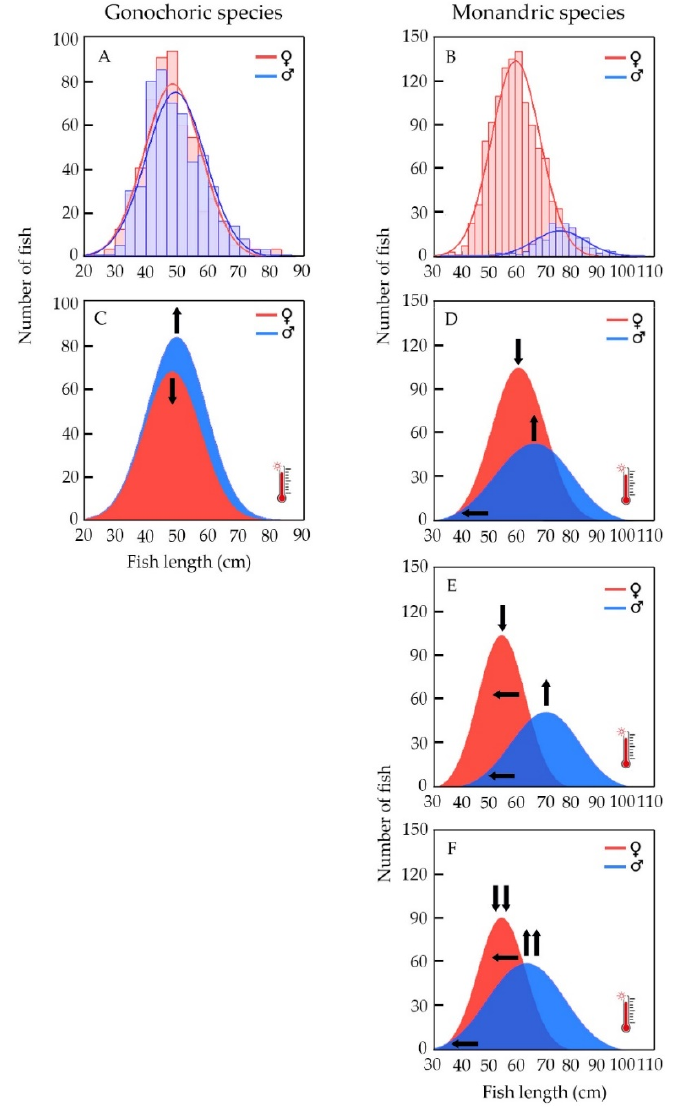
Figure 5. Hypothetical effect of climate change on population structure (size and sex-ratio) of gonochoristic (snapper) and hermaphroditic (grouper and wrasse) species. ( A ) Size–frequency distributions observed for female and male red snapper from the Campeche Bank [39], a repre- sentative gonochoristic fish. ( B ) Size–frequency distributions observed for female and male tiger grouper from the Campeche Bank [41], a representative monandric protogynous hermaphroditic fish. ( C ) Expected change in red snapper sex–size–frequency distributions caused by the effect of increasing water temperature on sex determination. ( D ) Expected change in tiger grouper sex–size–frequency distributions caused by the effect of increasing water temperature on sex determination. ( E ) Expected change in tiger grouper sex–size–frequency distributions caused by the effect of increasing water temperature on sex change. ( F ) Expected change in tiger grouper sex–size–frequency distributions caused by the effect of increasing water temperature on sex determination and sex change. Vertical arrows indicate an increase ( ↑ ) or a decrease ( ↓ ) in male or female propor- tion, respectively. Horizontal arrows ( ← ) indicate an increase or a decrease in male or female size range, respectively.